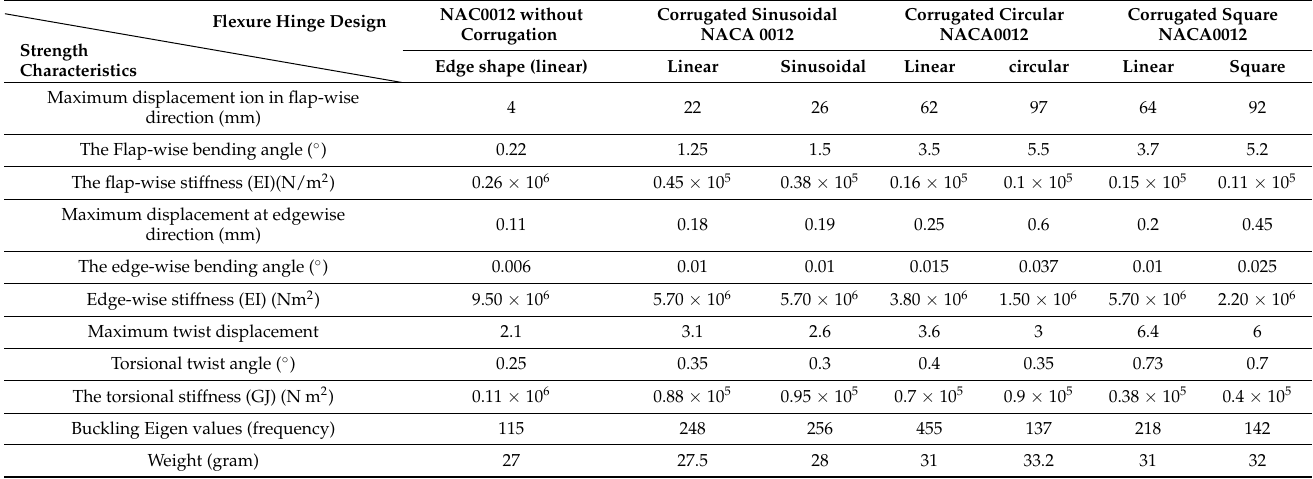
Table 1. The FE results and the calculated flap-wise, edge-wise, and torsional stiffness and weights of the 3d printed samples.